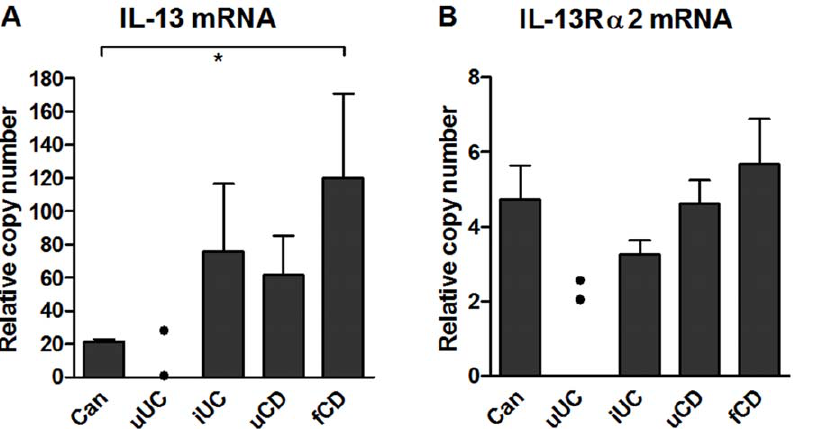
Figure 3. IL-13 transcription, but not IL-13R a 2 transcription, is increased fibrotic muscle. (A) IL-13 mRNA and (B) IL-13 R a 2 mRNA in muscle tissue lysates. RNA was extracted from tissue fragments and processed for qPCR. Results were normalized to four stably expressed housekeeper genes. Data are derived from 14–15 cancer controls, 2 uUC, 8 iUC, 8–12 uCD and 14–21 fCD patients. Significant differences from fibrotic CD, *p , 0.05.